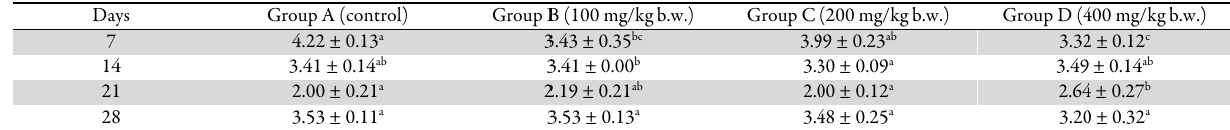
Table 4. Mean serum albumin (g/dl) level (means ± standard error) of rat groups administered methanol fruit extract of Piper guineense Days Group A (control) Group B (100 mg/kg b.w.) Group C (200 mg/kg b.w.)